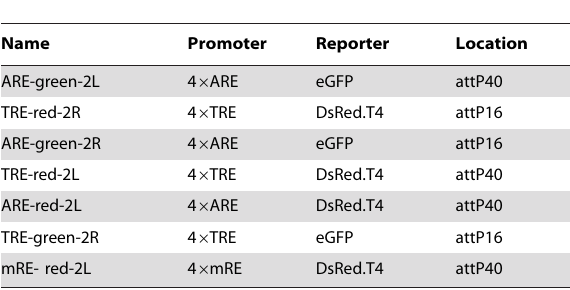
Table 1. Transgenic reporter fly lines.